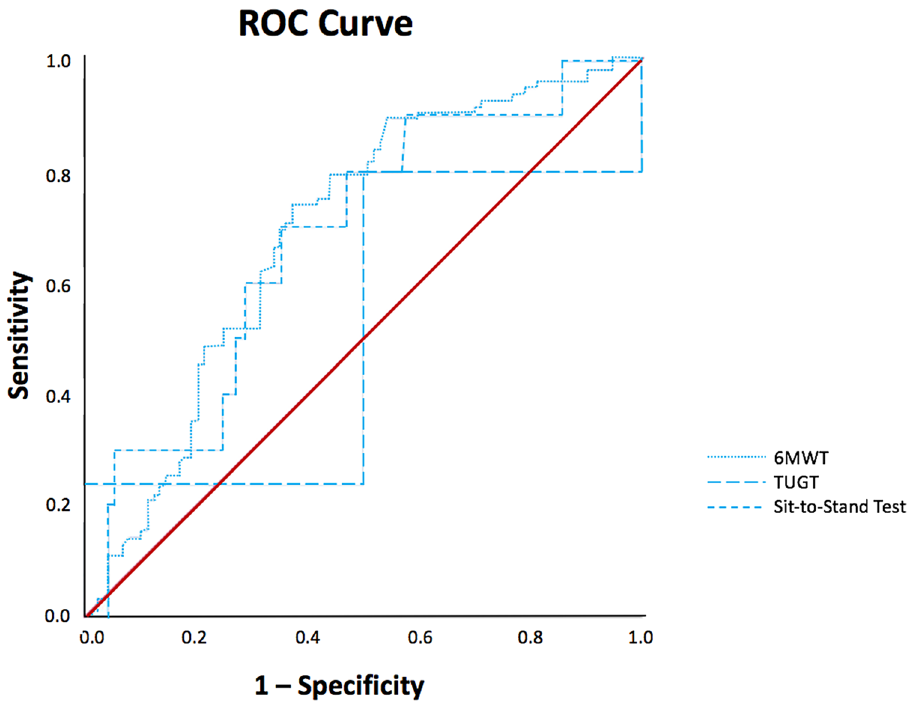
Figure 1. Receiver operating characteristics (ROC) curve for prediction of cut-off values of total sleep time. The area under the ROC curve (AUC) for 6MWT, TUGT and sit-to stand test were 0.689 ( P < 0.001), 0.517 ( P = 0.935) and 0.680 ( P = 0.056), respectively. 6MWT: 6-Minute Walk Test; TUGT: Time Up and Go